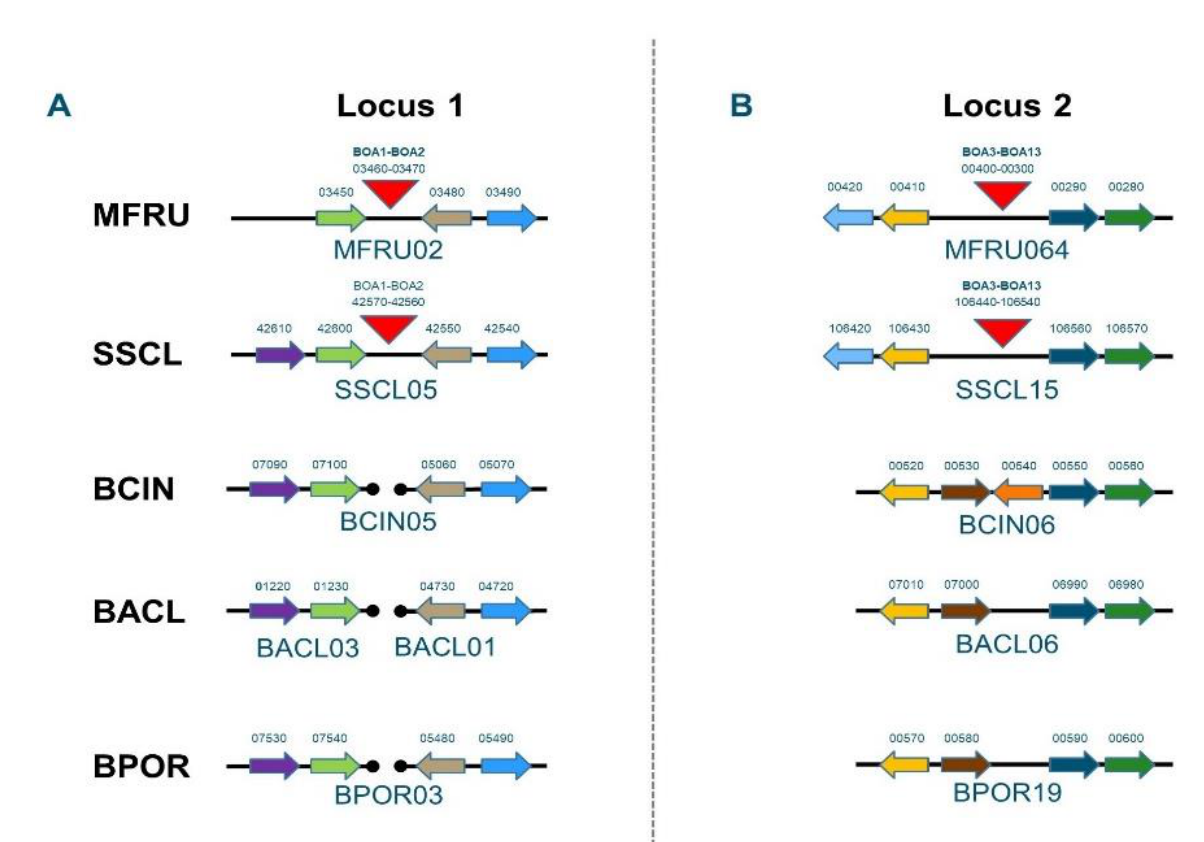
Figure 3. Configuration of M. fructicola botcinic acid (BOA) biosynthetic genes in two clusters (panels A , B ), as compared to homologs in S. sclerotiorum , B. cinerea , B. aclada and B. porri . Contig numbers in the five species are provided underneath the locus. Orthologous genes are in identical colours. Gene numbers within the contig are provided above the gene, with the arrow indicating the direction of transcription. The triangular red blocks represent the BOA cluster. Synteny breaks are shown by interrupted lines with dots marking the break.